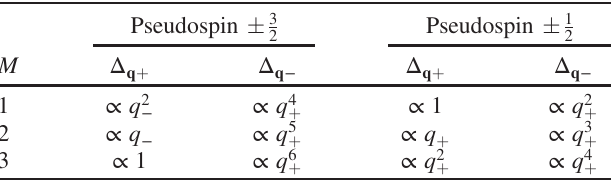
and Δ for q þ q − ). We have defined q − Fermi 2